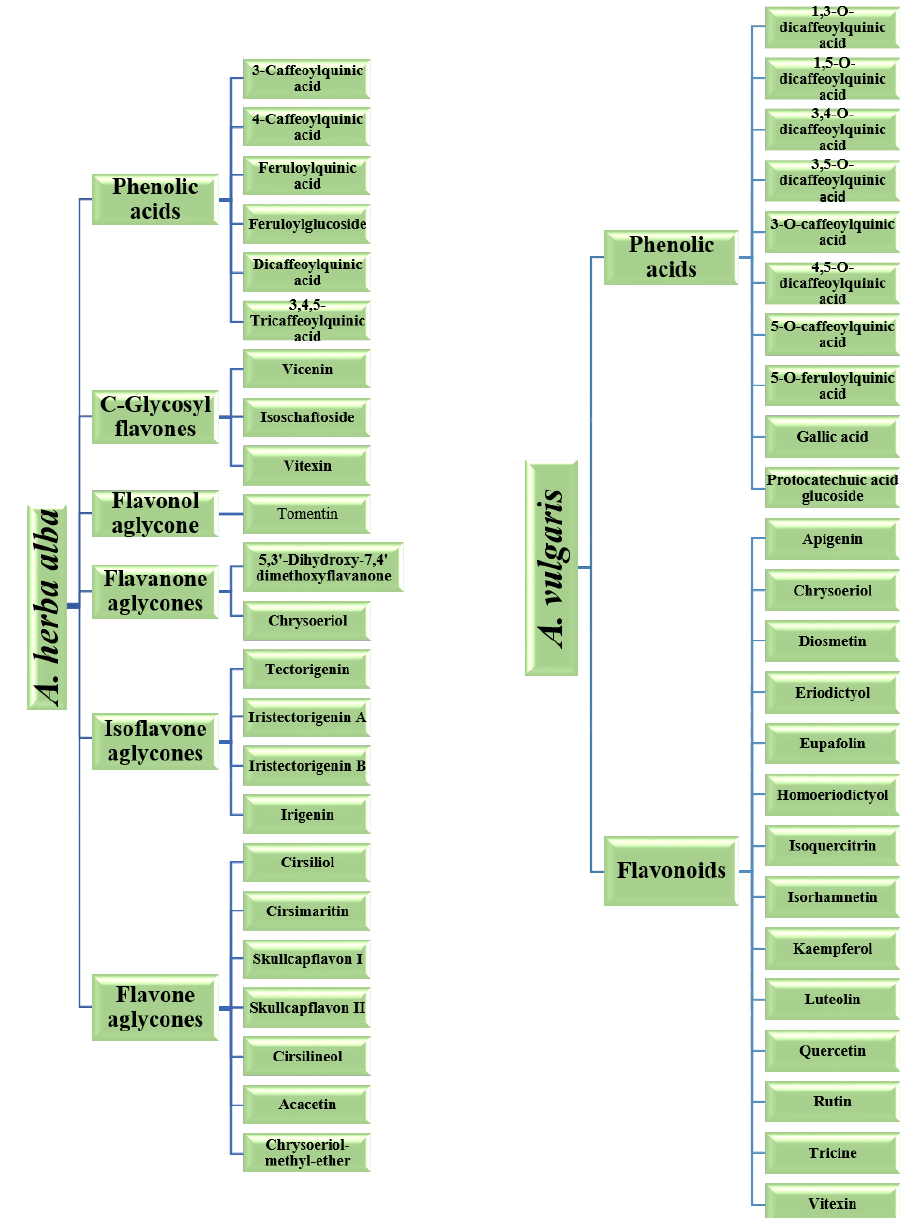
Figure 9. Various bioactive compounds found in A. herba alba [17] and A. vulgaris [5].